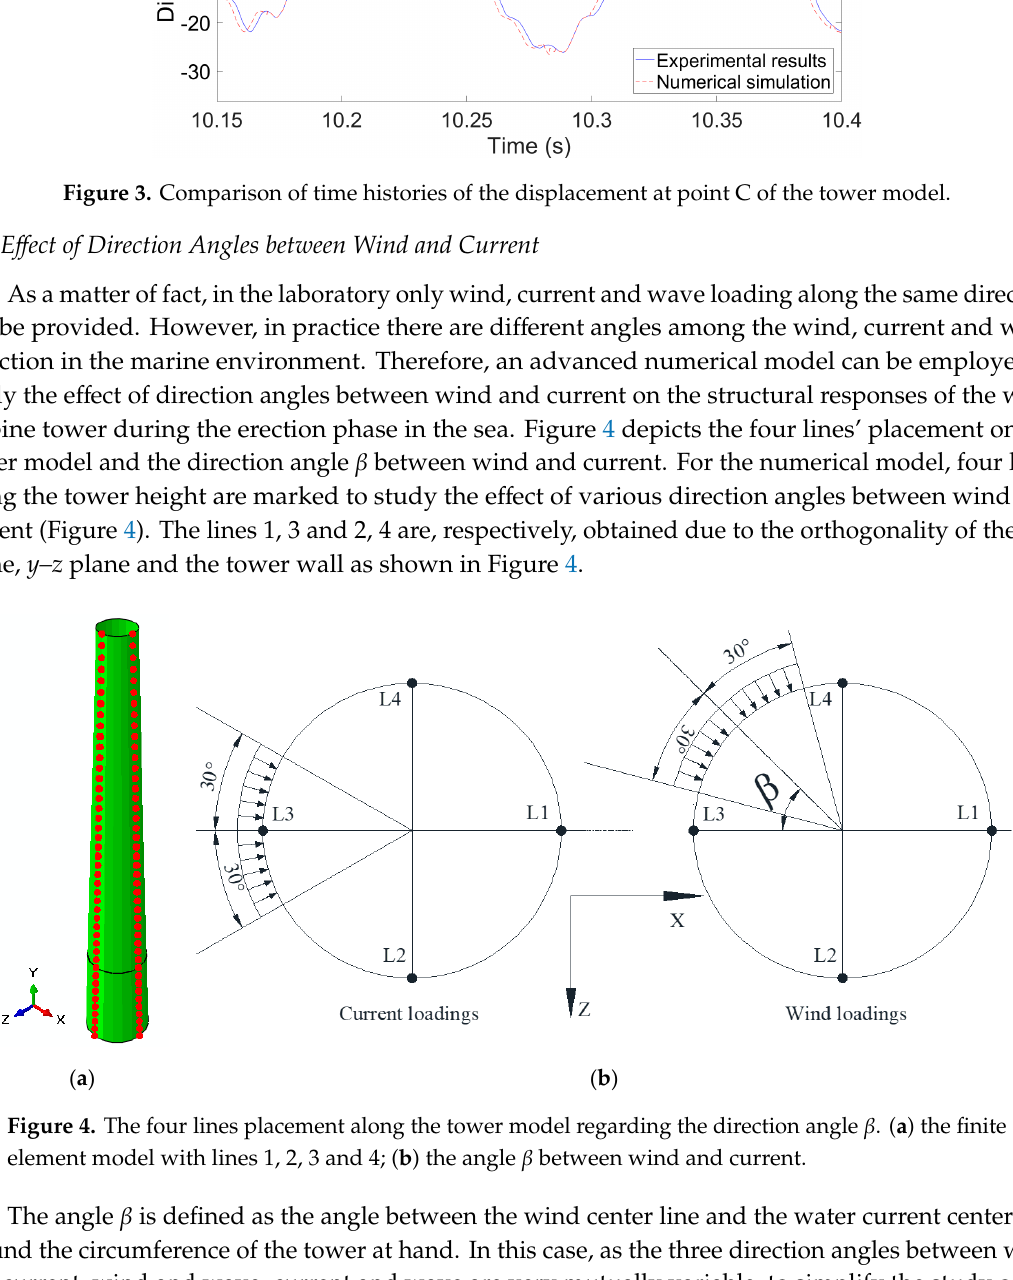
Figure 4. The four lines placement along the tower model regarding the direction angle β . ( a ) the finite element model with lines 1, 2, 3 and 4; ( b ) the angle β between wind and current.